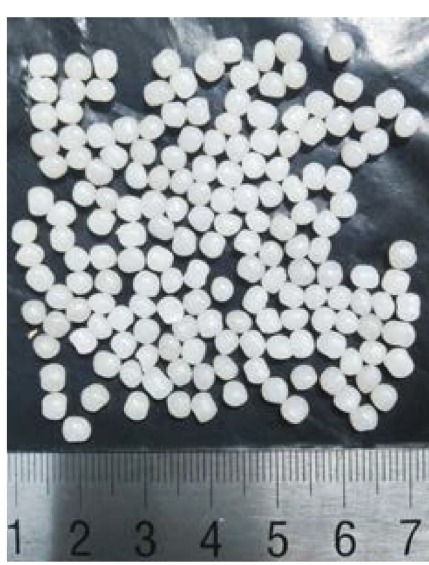
Figure 3: Experimental